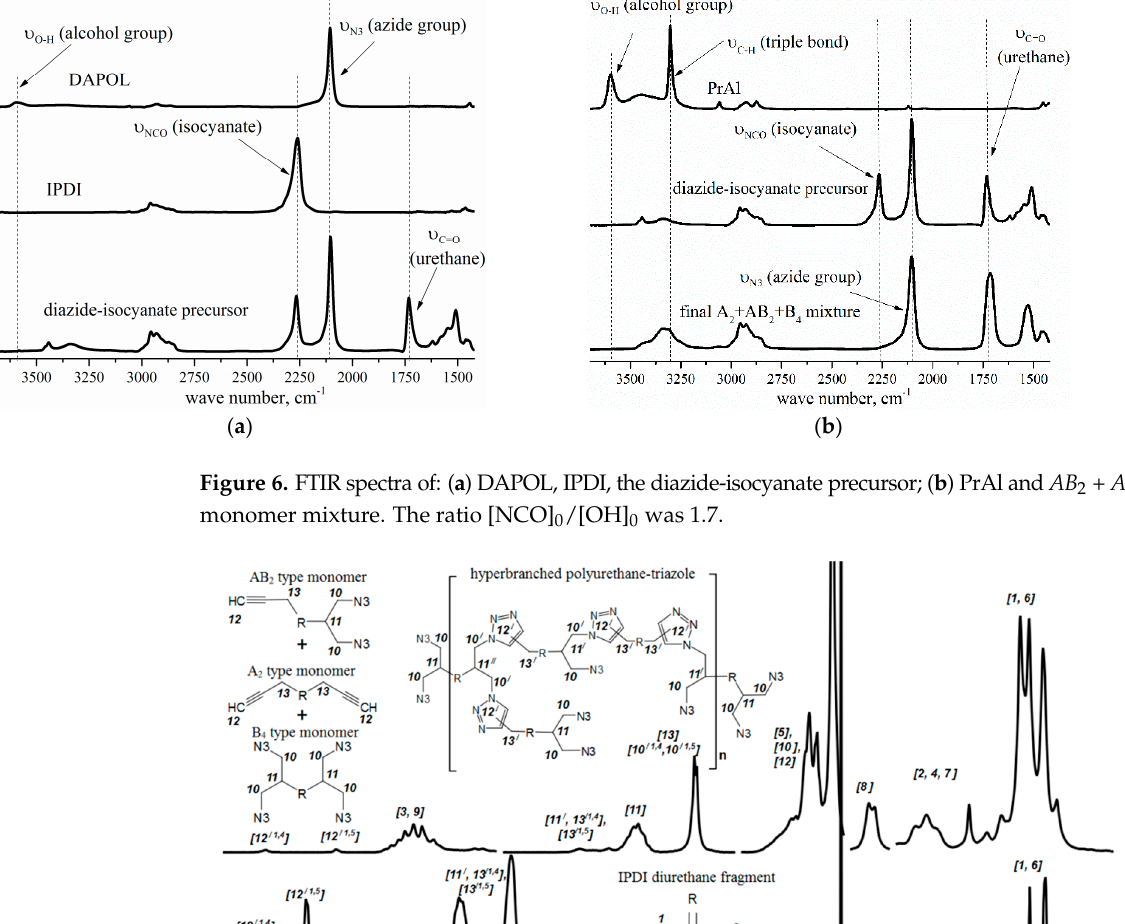
Figure 6. FTIR spectra of: ( a ) DAPOL, IPDI, the diazide-isocyanate precursor; ( b) PrAl and AB 2 + A 2 +B 4 monomer mixture. The ratio [NCO] 0 /[OH] 0 was 1.7.